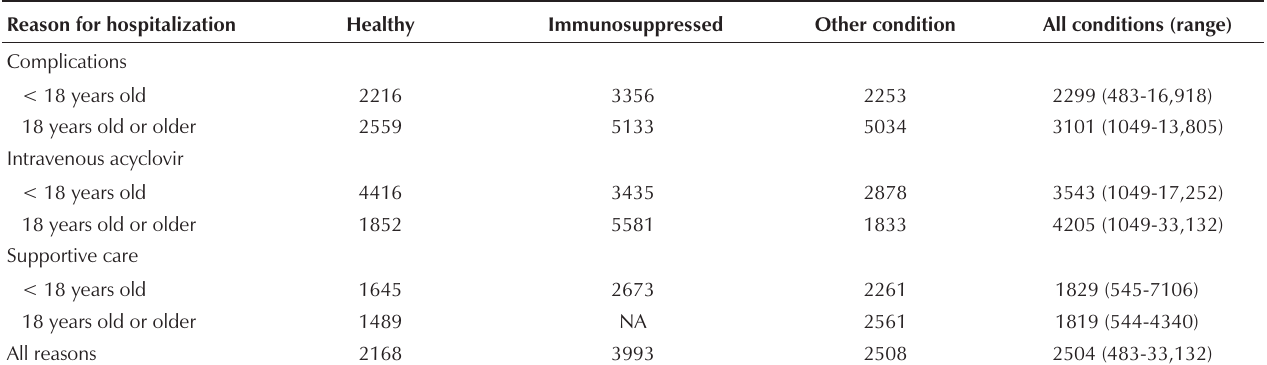
Average cost of hospitalizations by type of hospitalization and health condition, and age category, Quebec, April 1994